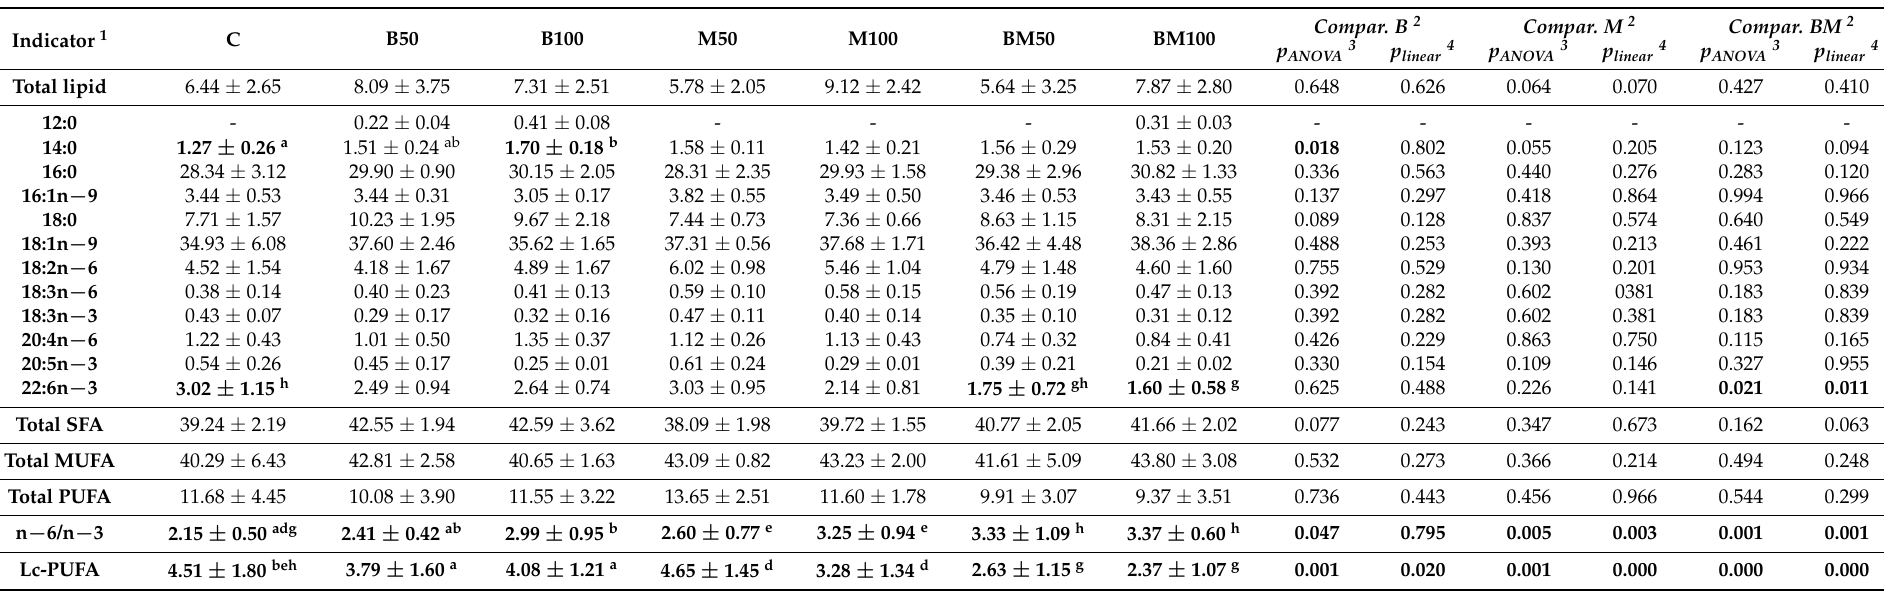
Table 8. Total lipid (% wet weight) and fatty acid composition (% of total fatty acids) of liver after feeding period using diets with different inclusion levels of M and B (n = 6/diet